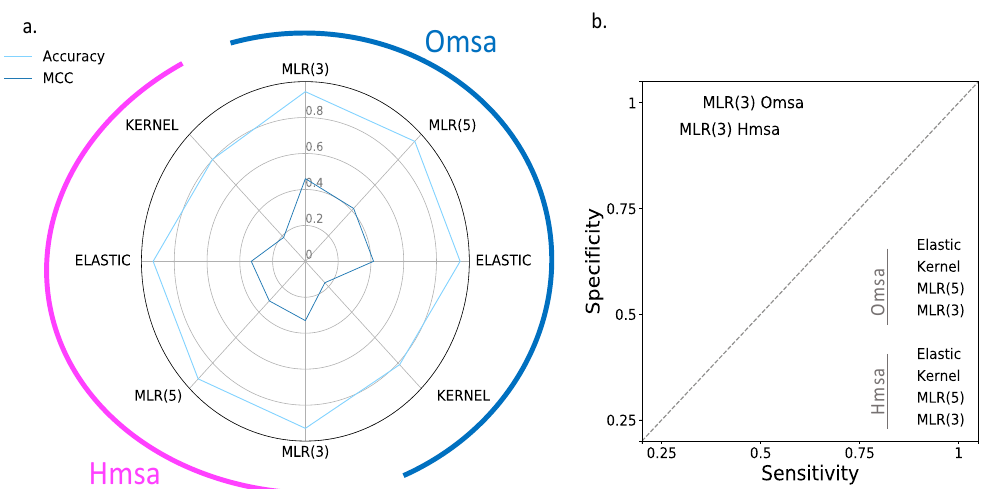
Figure 7. Performance of endophenotype-based pathogenicity predictions. BRCA2 case. Using functionality thresholds (see Material and Methods), we transformed the endophenotype estimates into benign/pathogenic predictions. The success rate of these pathogenicity predictions is described using four standard parameters: ( a ) Accuracy/MCC and ( b ) sensitivity/specificity. In ( a ), the half-circles external to the radar plot identify the results obtained with different multiple sequence alignments: Omsa (blue) and Hmsa (pink). In ( b ), we use different colors to establish this difference. For reference, we located the MLR model obtained using three features only.